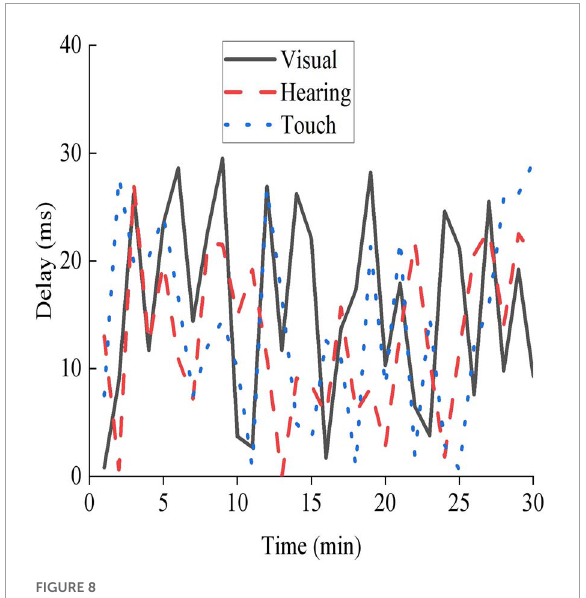
FIGURE8 Basic performance testing status of VR equipment.